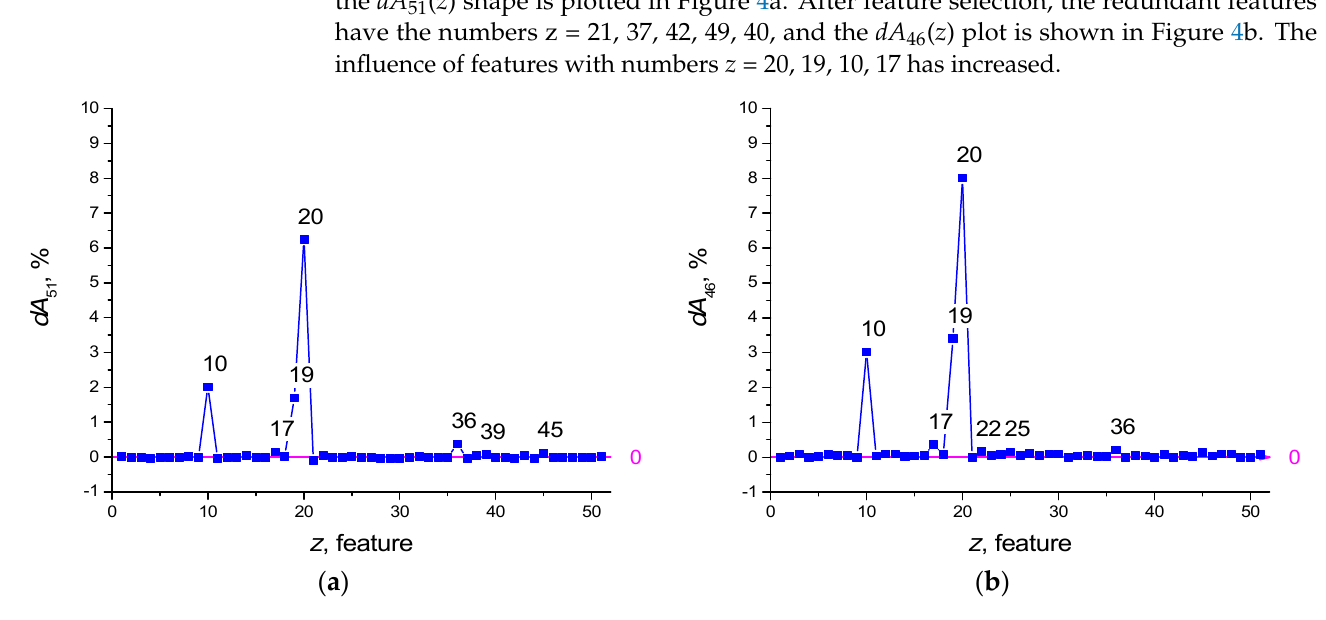
Figure 4. Function of the feature strength dA 51 ( z ) ( a ), dA 46 ( z ) ( b ). The dependence of A 46 ( FR [21,37,40,42,49]) on the number of epochs is shown in Figure 5, and the values of other metrics are shown in Table